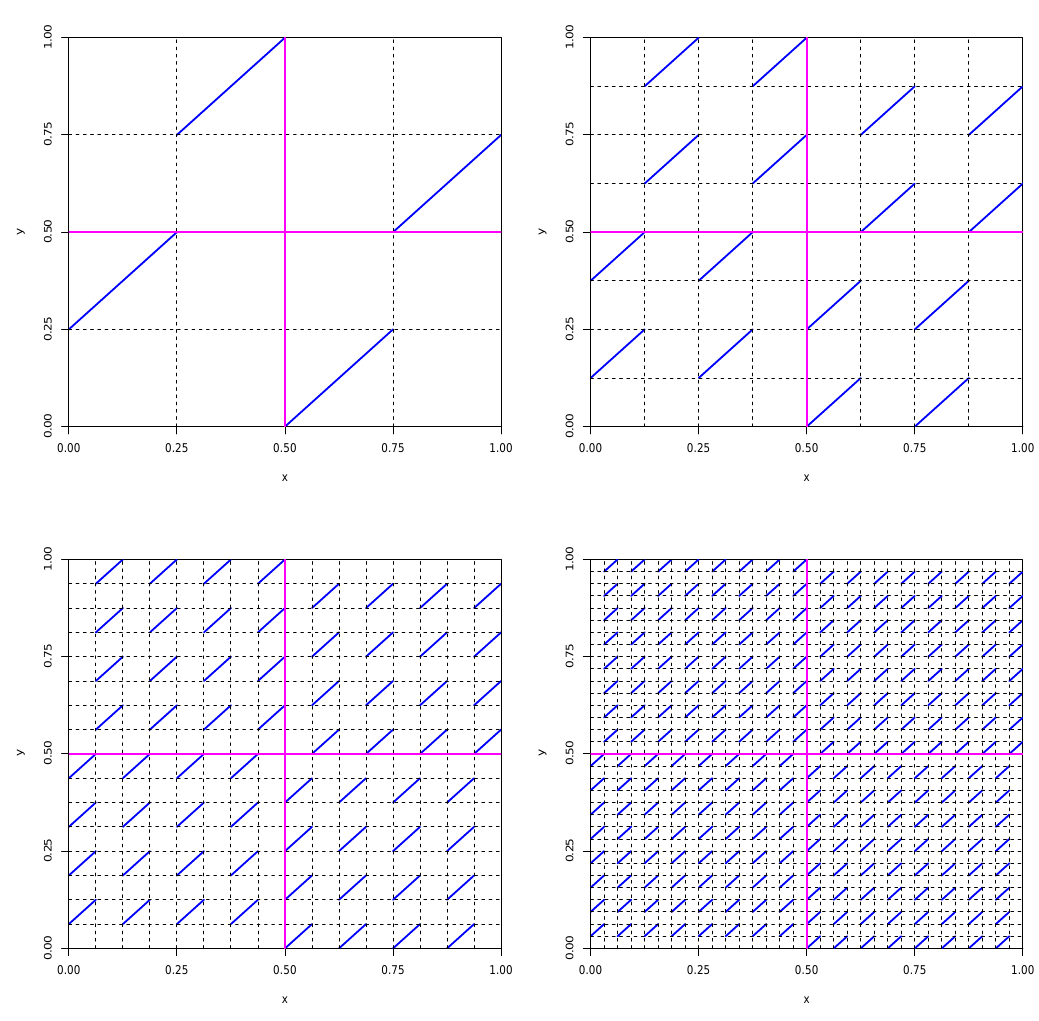
Figure 3: The copulas A 1 , A 2 , A 3 , A 4 used in Example 5.1; each of them concentrates its mass uniformly on the blue segments.